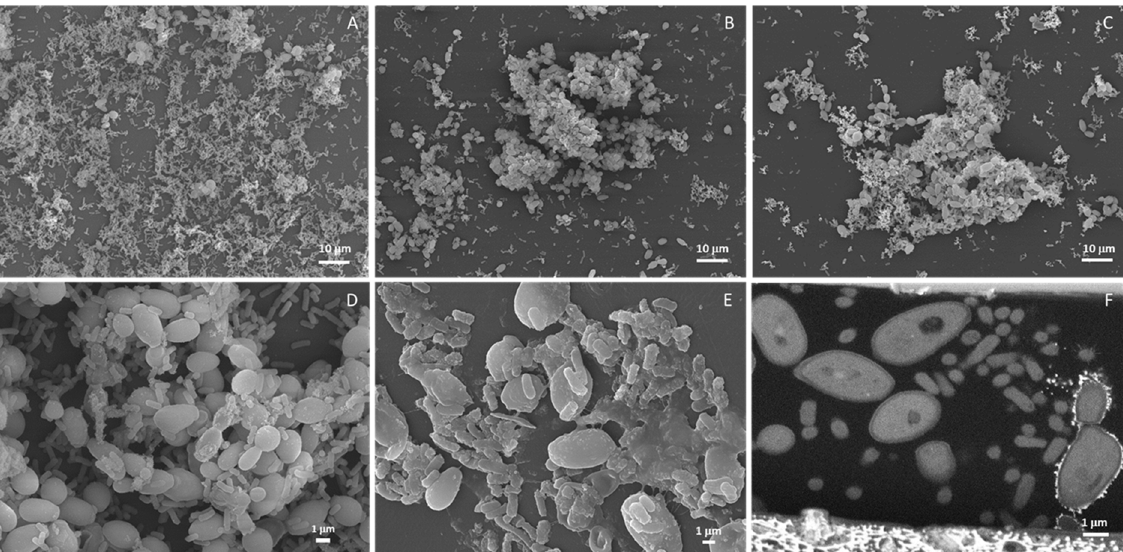
Figure 4. Dual biofilms. Biofilm started by a mix of C. parapsilosis and E. cloacae complex ( E. bugandensis ) ( A ), C. parapsilosis ( B ) or E. cloacae complex ( E. bugandensis ) ( C ) on polystyrene plates. Detail of mixed biofilm, started by the two microorganisms, on polystyrene ( D ) and polyurethane ( E ) acquired by SEM. Section of a dual biofilm assembled in the lumen of a polyurethane central venous catheter ( F ) acquired by FIB-SEM.